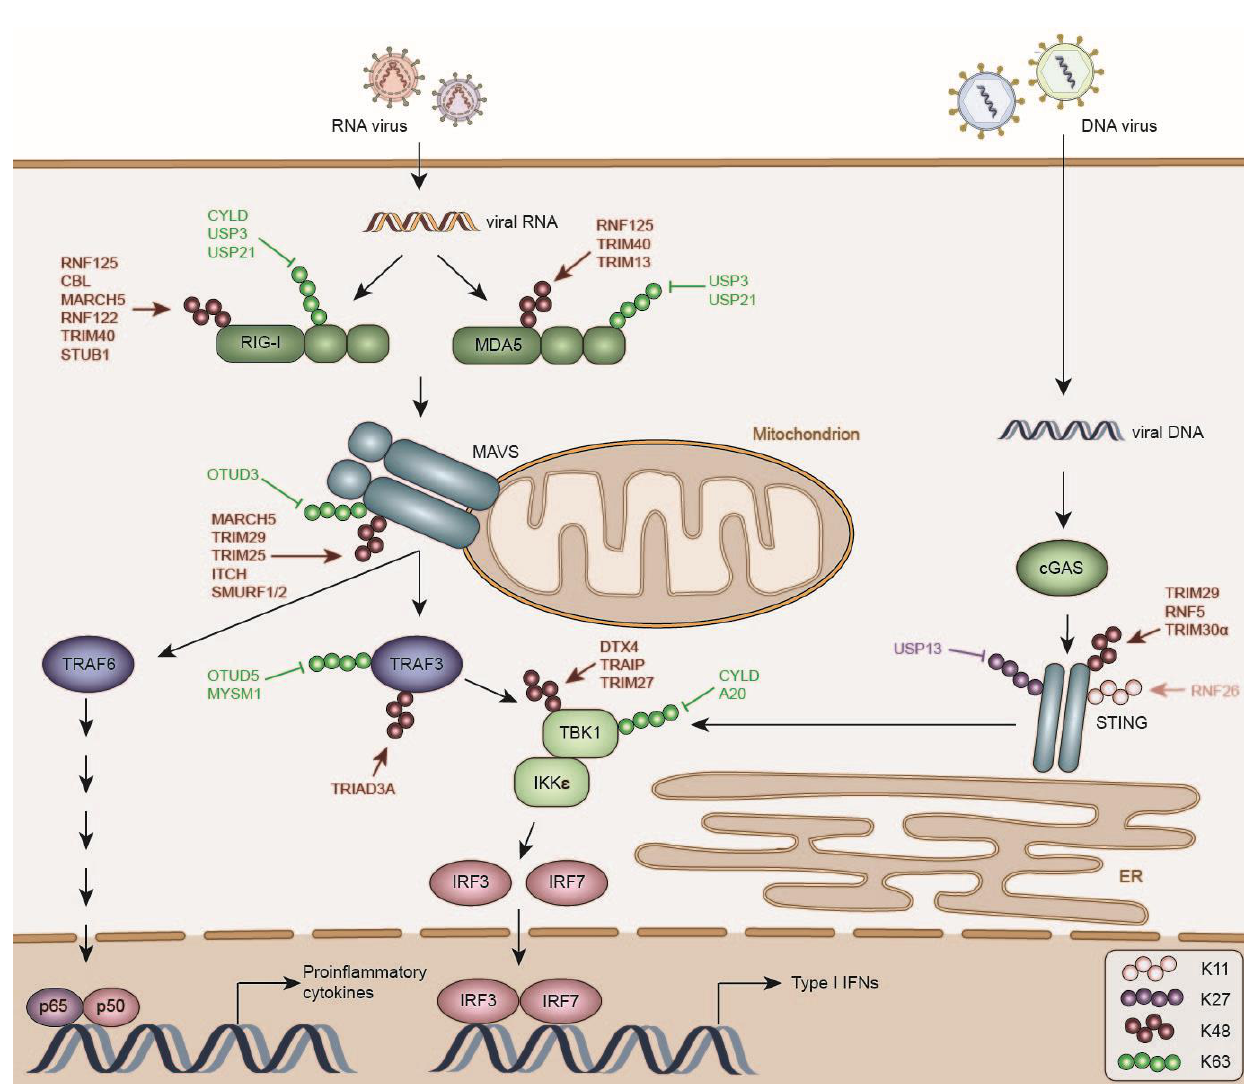
Figure 1. Negative regulation of cytoplasmic RNA and DNA sensor pathways. Viral 5′ppp RNA, or longer double-stranded (ds)RNA are recognized by the sensors Retinoic Acid-Inducible Gene I (RIG-I) and Melanoma Differentiation-Associated 5 (MDA5), respectively. Subsequently, activation of these sensors activates Mitochondrial Antiviral Signaling (MAVS) at the mitochondria, which in turn activates two different kinases. Tumor Necrosis Factor (TNF) Receptor Associated Factor 2 (TRAF) Family Member Associated Nuclear Factor κB (NFKB) Activator (TANK) Binding Kinase 1 (TBK1)/Inhibitor of Nuclear Factor Kappa B Kinase Subunit Epsilon (IKKε) phosphorylate Interferon Regulatory Factor 3 (IRF3), which translocates to the nucleus, where it drives type I interferon (IFN) transcription. In addition, the classic IKKα/β/NFκB Essential Modifier (NEMO) kinase complex is activated downstream of TRAF6 (displayed in detail in Figure 2), which results in phosphorylation and degradation of IκBα, the inhibitor of NFκB. Upon release of its inhibitor, NFκB translocates to the nucleus, where it drives transcription of pro-inflammatory response genes. Poly-ubiquitin chains on each molecule are shown in different colors, depending on their linkage type: K11 (light red), K27 (purple), K48 (dark red), K63 (green). Names of deubiquitinating enzymes (DUBs) removing activating K63 poly-ubiquitin chains are listed in green, and K27 chains in purple, whereas E3 ligases adding degradative K11 or K48 chains are displayed in light or dark red. RLRs are constitutively expressed, and reside in the cytoplasm of uninfected cells in an auto-repressed, inactive state [48,49]. Viral RNA binding to RIG-I triggers its con- formational change and oligomerization, promoted by ubiquitination by the E3